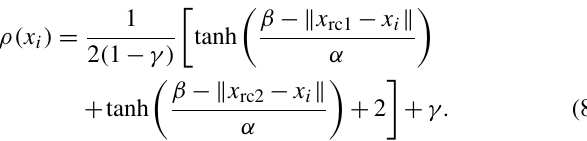
Figure 2. A schematic diagram of the hierarchical refinement mesh, illustrating the function of three parameters of the density function. α 1 and α 2 control the width of the transition zones, λ represents the inner densification ratio between the first-refinement and second- refinement resolution regions, and β 1 and β 2 control the coverage radius of the first-refinement and second-refinement